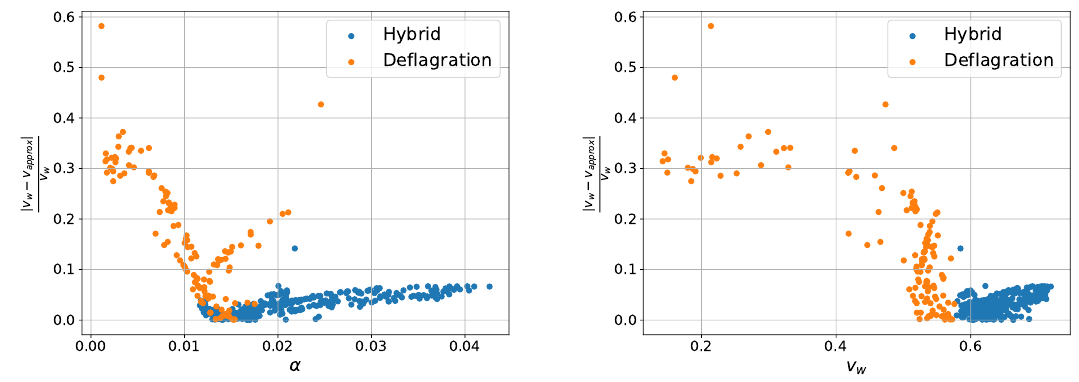
Figure 4 . Relative errors in the wall velocity between the analytic approximation and the full calculation for deflagration points (orange) and hybrids